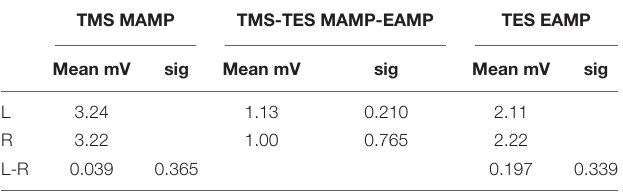
TABLE 5 | Survey of mean muscular MEP amplitudes for TMS and TES, indicated as MAMP and EAMP, respectively and their differences between TMS and TES for left (L) and right (R) sides and differences between sides